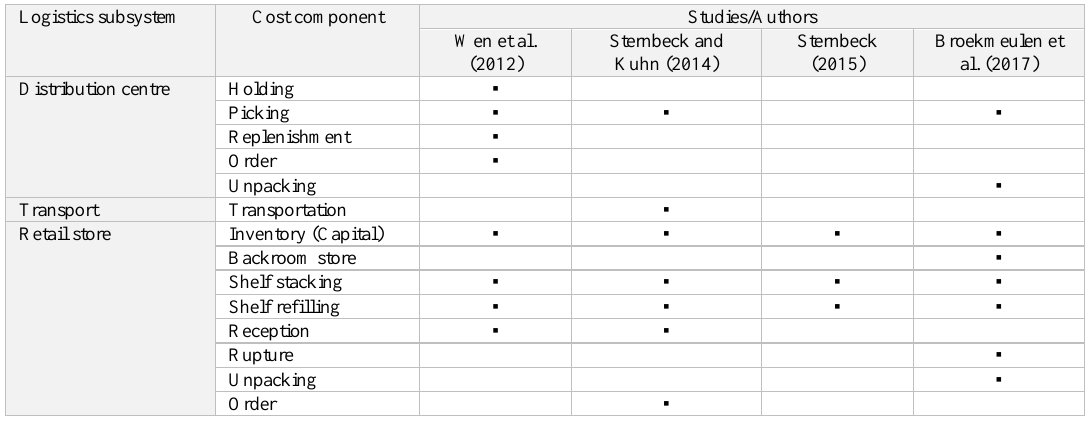
Table 1. Logistics cost components used in the models for dimensioning the